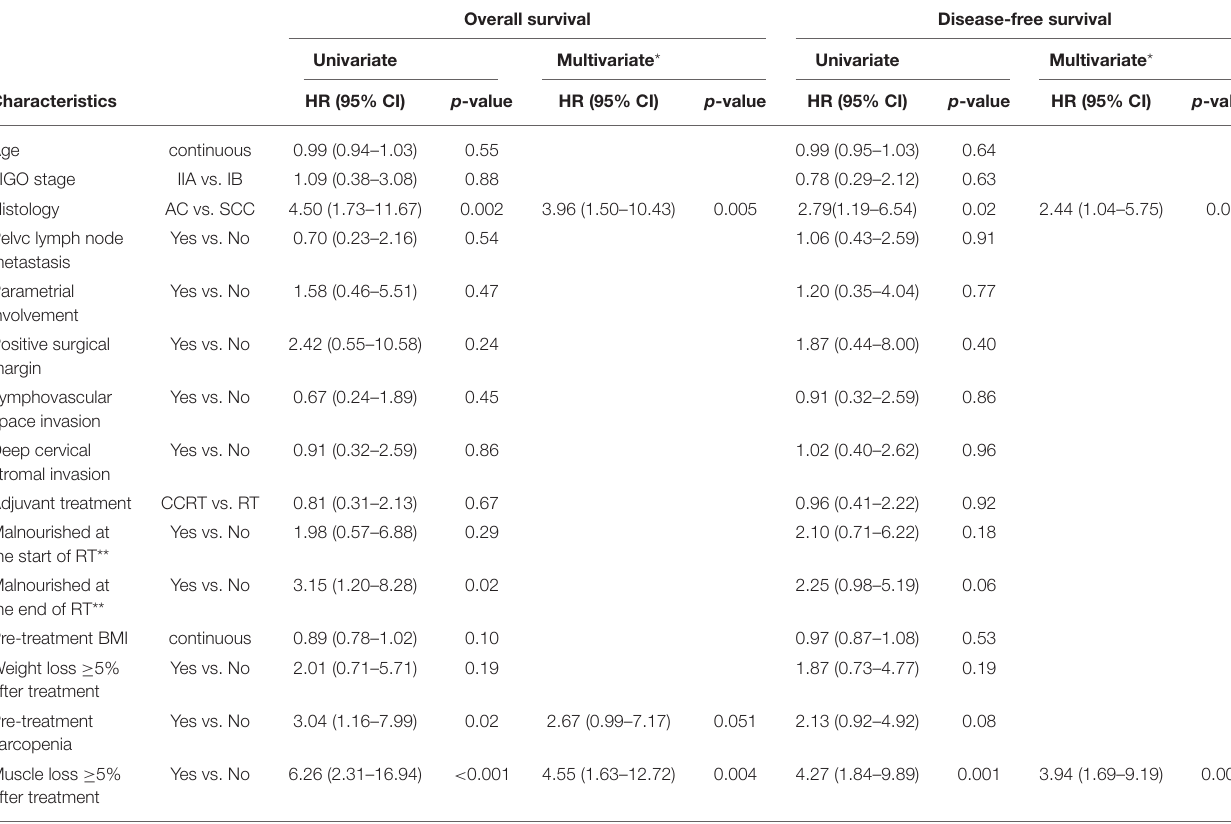
TABLE 3 | Univariate and multivariate analyses of factors associated with overall survival and disease-free survival. Overall survival Disease-free survival Univariate Multivariate * Univariate Multivariate